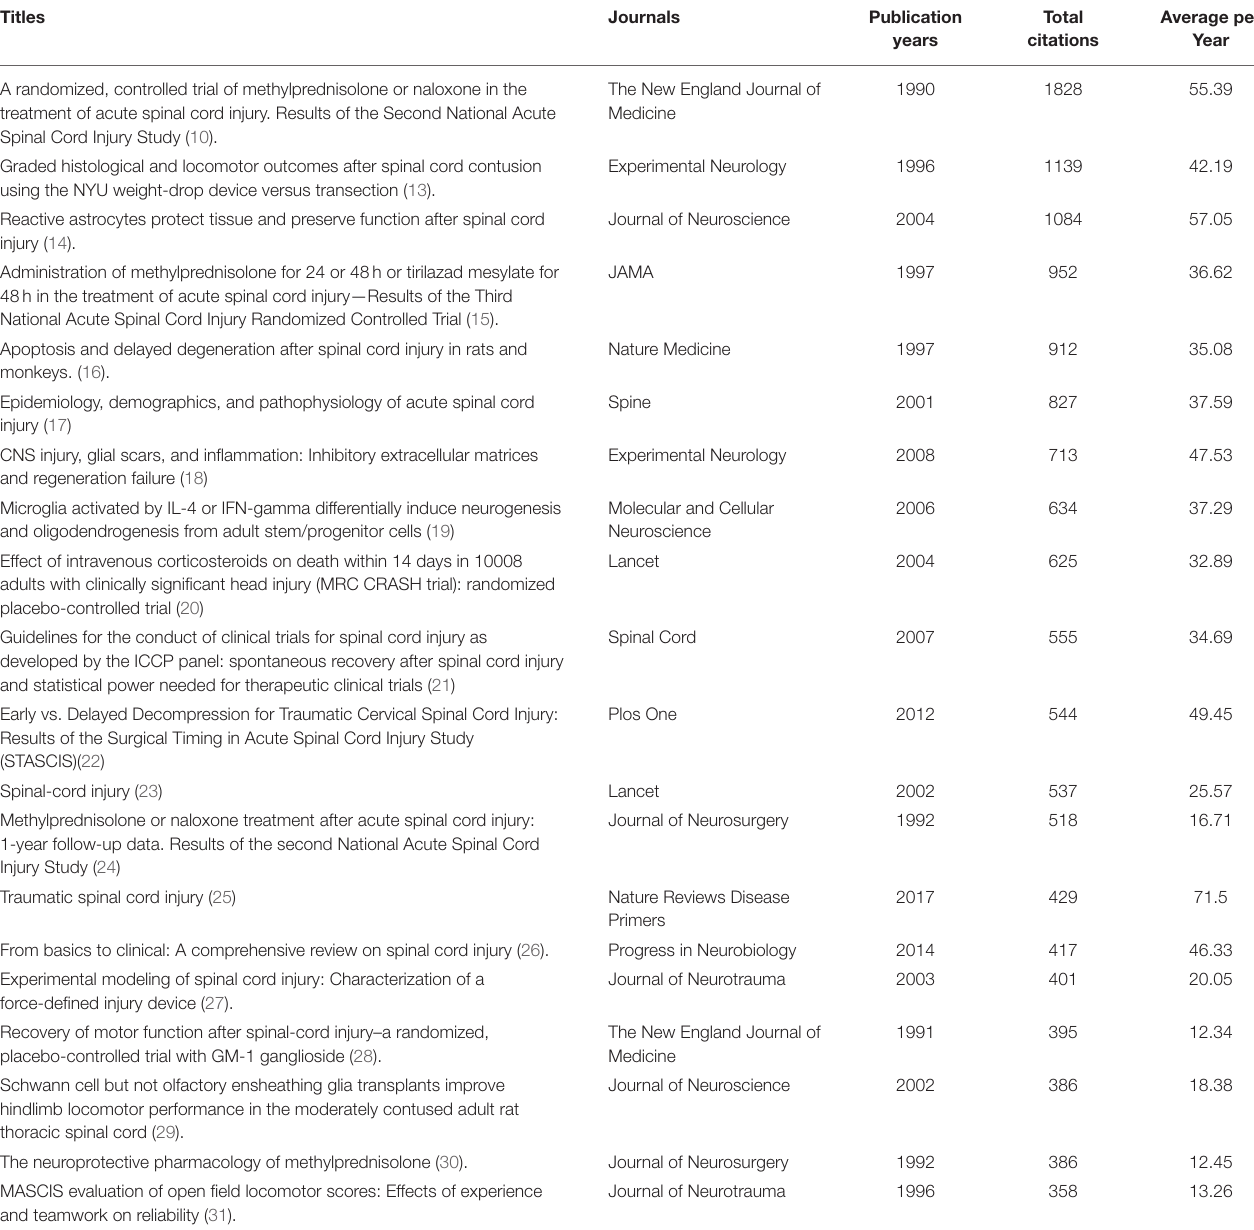
TABLE 1 | Top 20 articles on Spinal cord injury (SCI) and glucocorticoid in Web of Science from 1982 to